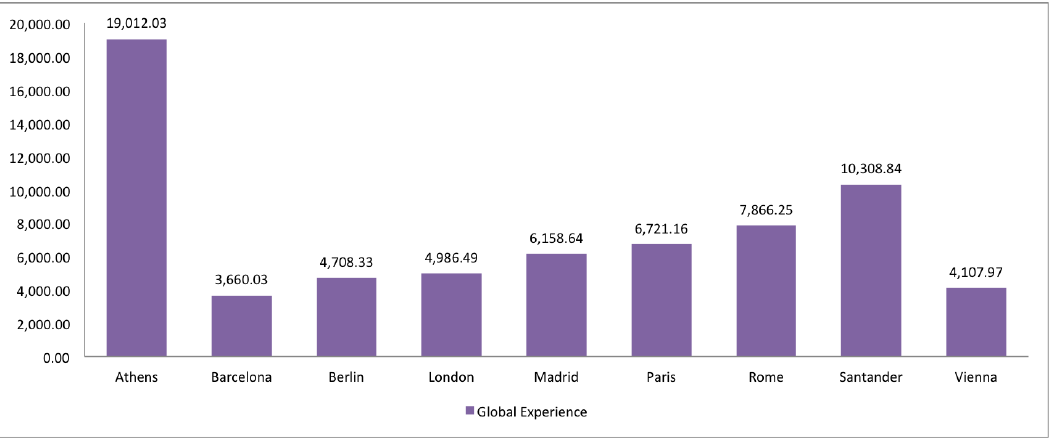
Figure 30. Trust study in Europe: global experience. Average number of contributions in the planet by